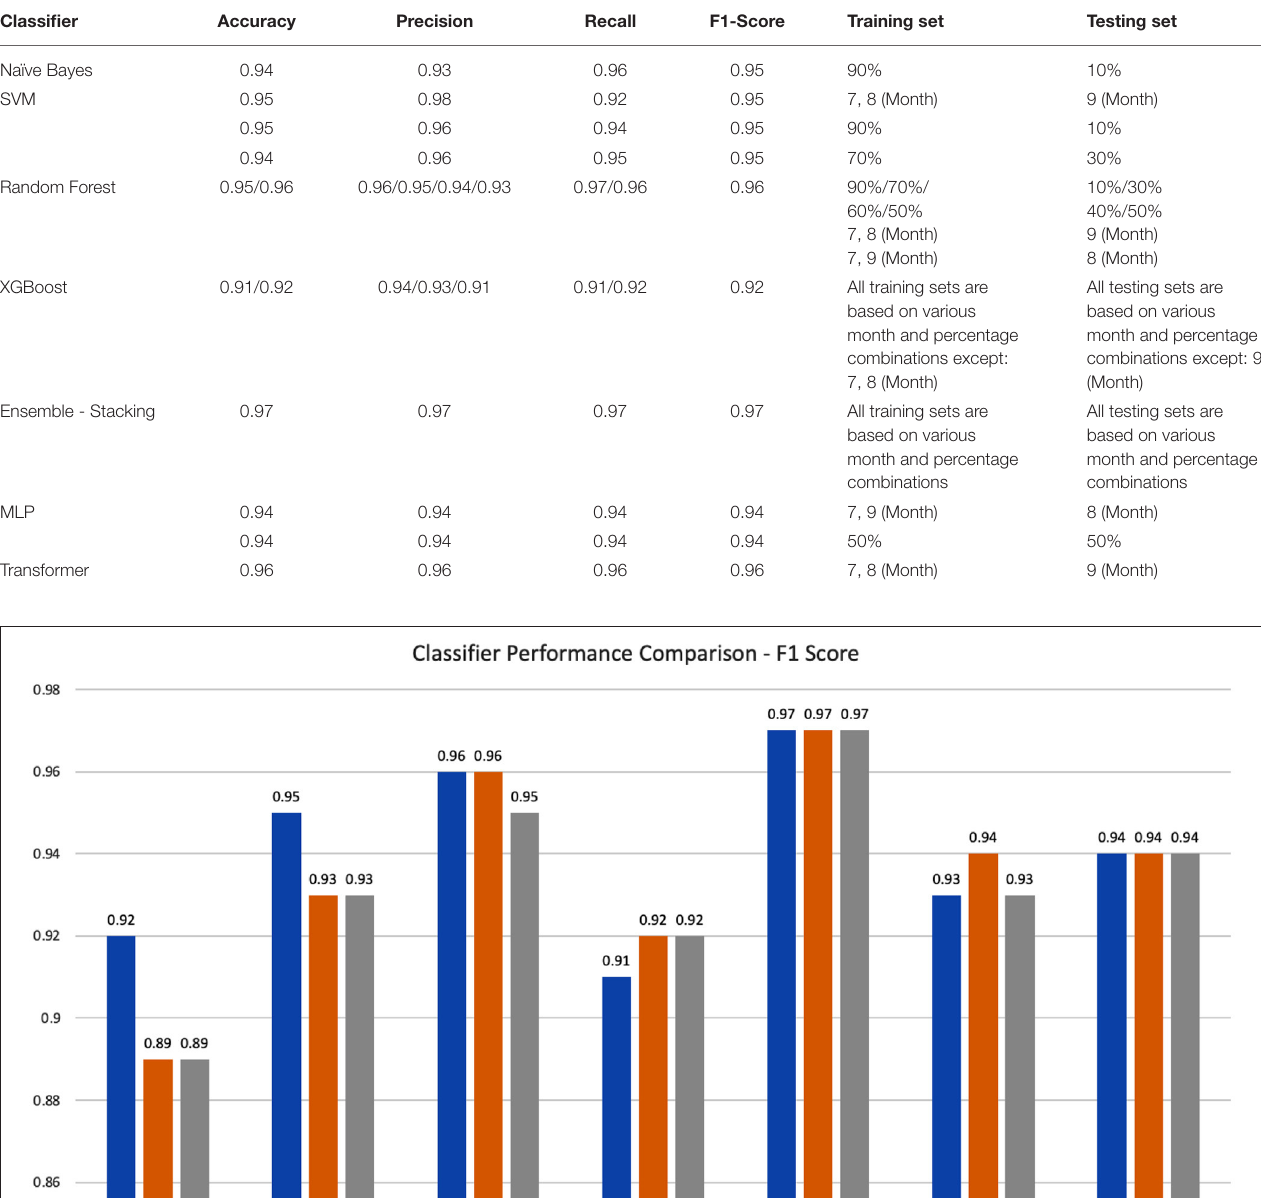
TABLE 3 | Best performance (F1-score) achieved for each classifier.